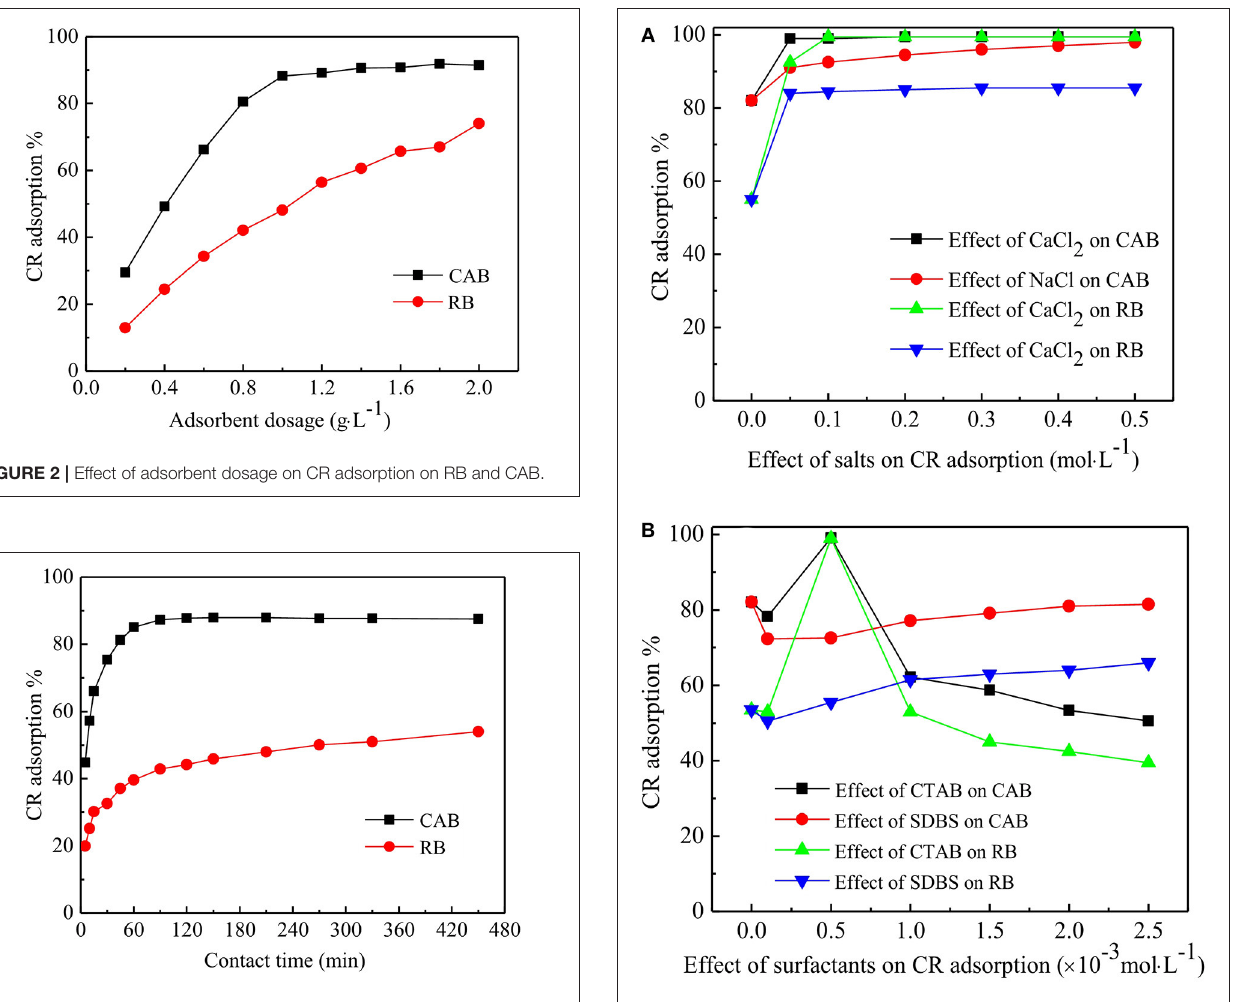
FIGURE 3 | Effect of contact time on CR adsorption on RB and CAB. FIGURE 4 | Effect of inorganic salt (A) and surfactants (B) on CR adsorption on RB and